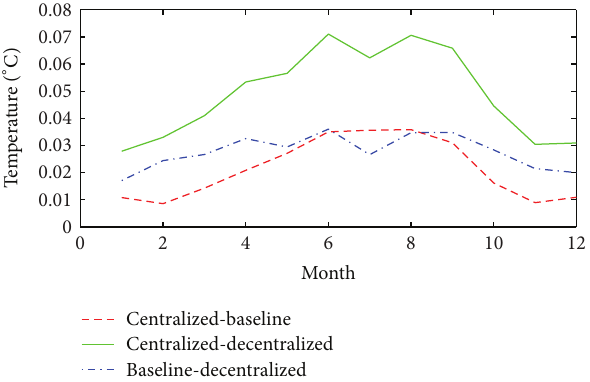
Figure 5: Temperature difference under different